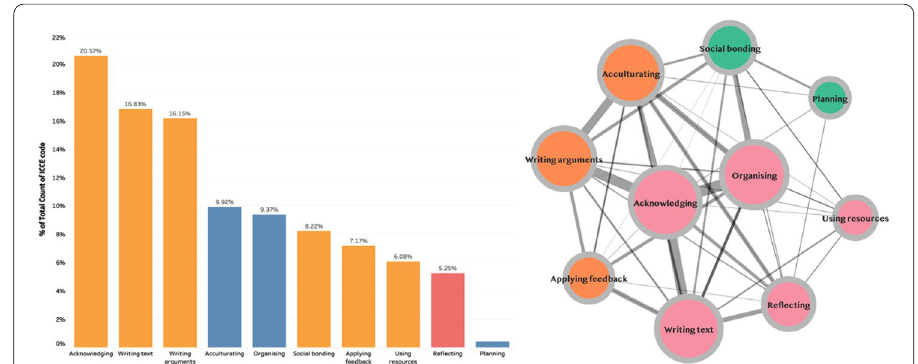
Fig. 1 A distribution graph of students’ SRL tactics and an aggregate social network graph in which the nodes represent students’ SRL tactics and the thickness of the edges is proportional to the frequency of connections between them. Nodes with similar colours occur more frequently